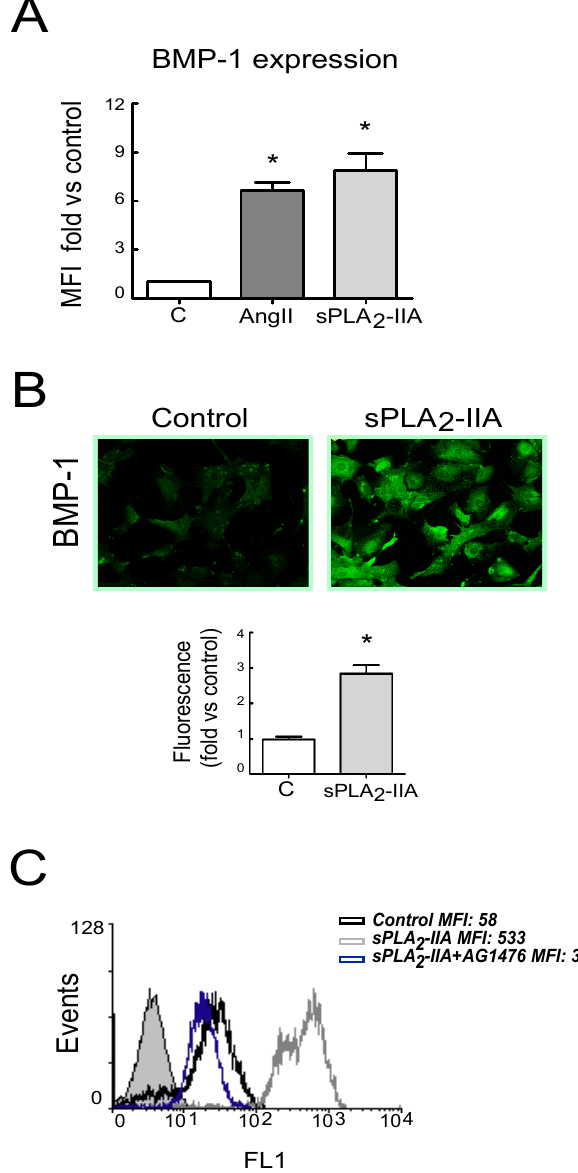
Figure 7. sPLA 2 -IIA induces BMP-1 expression in cardiac fibroblast (CFs) via EGFR transactivation. CFs were treated with 1 µ g / mL of sPLA2-IIA or 1 µ M AngII for 24 h and BMP-1 protein expression was evaluated by ( A ) flow cytometry analysis. The graphic represents the mean fluorescence intensity (MFI) and was shown by fold control. ( B ) Representative microphotographs of resting and 24 h sPLA 2 -IIA-stimulated cells examined by fluorescence microscopy (objective lens 20 × , magnification 200 × ) and quantification. ( C ) CFs, pretreated with the EGFR inhibitor AG1476, were stimulated with 1 µ g / mL of sPLA 2 -IIA for 24 h. BMP-1 expression was analyzed by flow cytometry: untreated cells (open black curves) were compared with sPLA 2 -IIA-treated cells in the absence (open dark grey curves) or presence of the inhibitor (open blue curves). Solid light grey curve shows isotype control. Representative histograms are shown, n = 3. Bar graphs represent the mean ± SD; n = 3. * p < 0.001 vs. control cells.